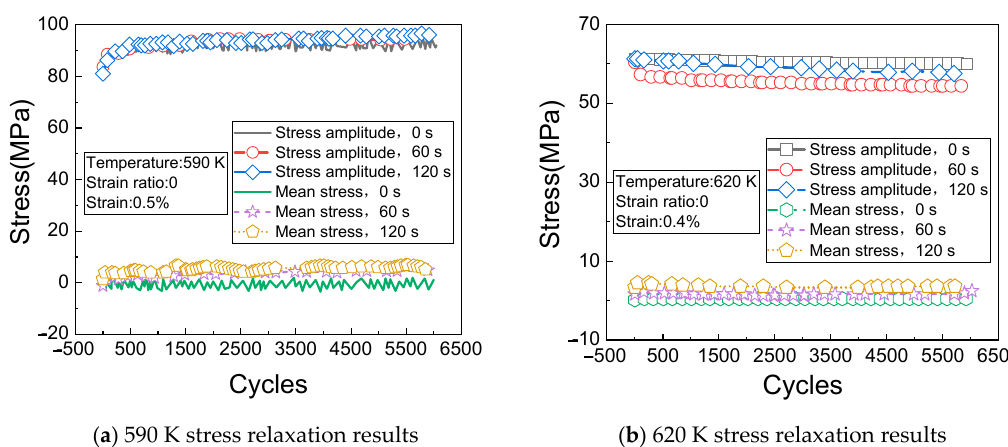
Figure 9. Stress relaxation results at 590 K and 620 K. ( a ) 590 K stress relaxation results; ( b ) 620 K stress relaxation results.